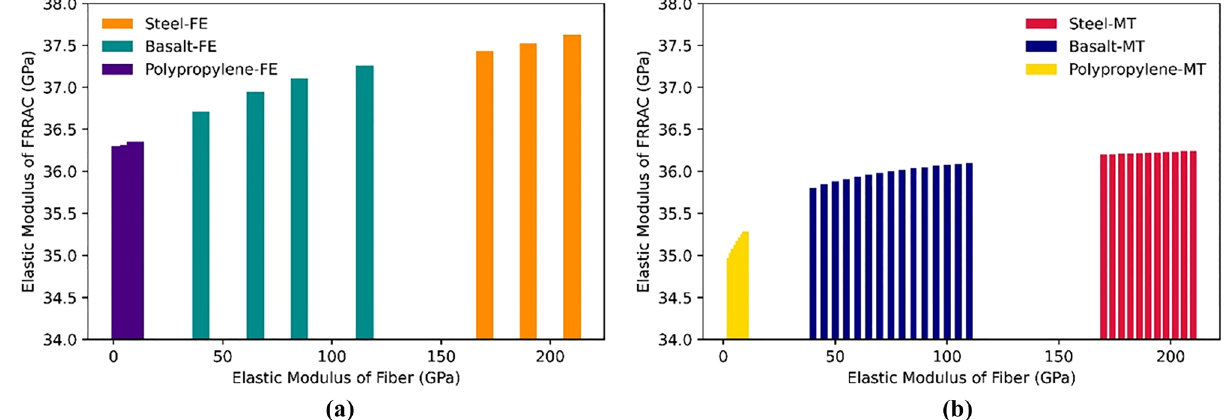
Figure 11. The elastic modulus of FRRAC based on fiber elastic modulus: ( a ) FE approach, ( b ) MT approach.